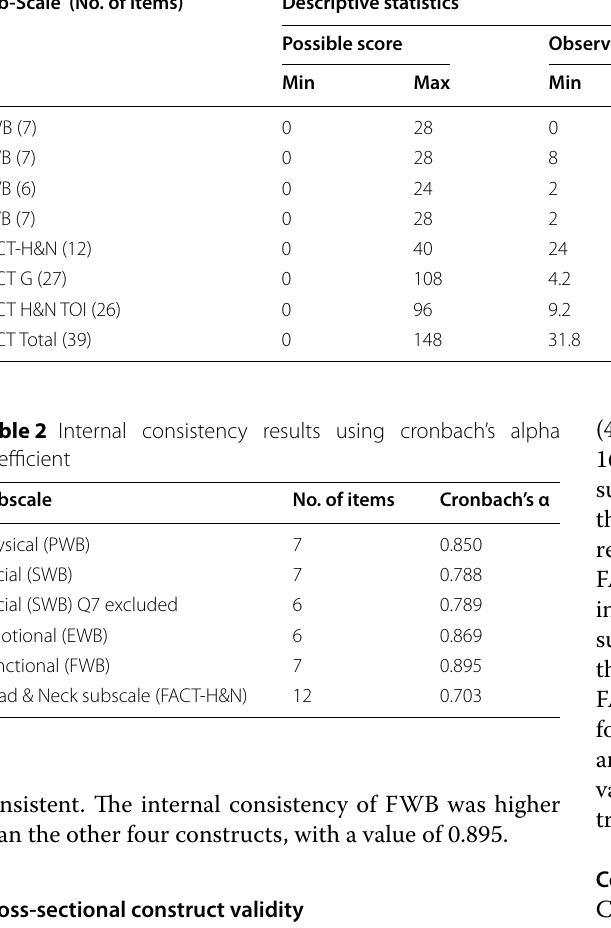
Table 1 Test-retest reliability results using ICC—Higher scales indicate better QOL Sub‑Scale (No. of items)